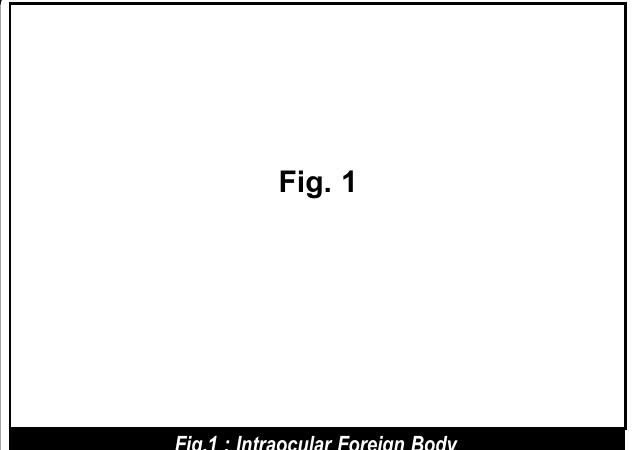
Fig.1 : Intraocular Foreign